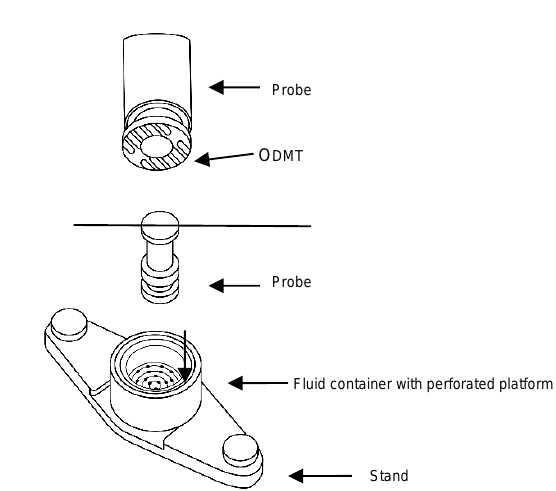
Figure 1. Schematic illustration of disintegration time rig of the texture analyzer.